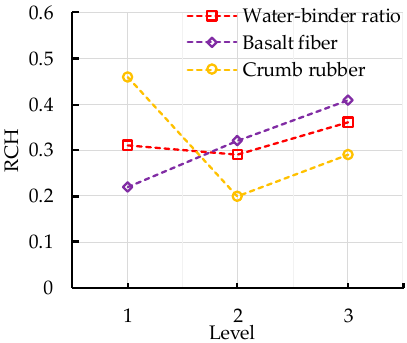
Figure 8. Effects of water–binder ratio, basalt fiber content and crumb rubber replacement rate on RCH .